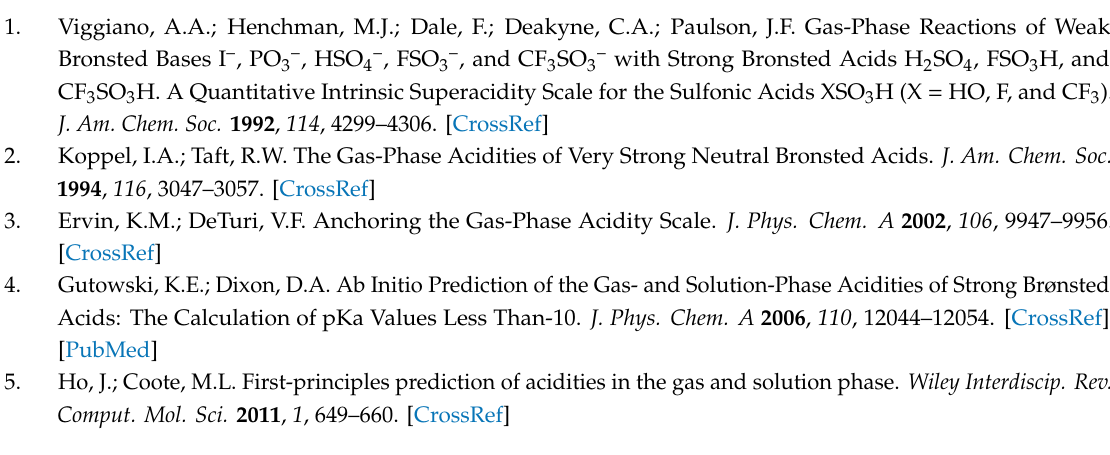
Supplementary Materials: The following are available online. Table S1. Experimental (gas-phase electron di ff raction—GED) and calculated (B3LYP / cc-pVTZ // MP2 / cc-pVDZ // МР 2 / cc-pVTZ) geometries (angstroms and degrees) of unsubstituted BSA [42], Table S2. Experimental (GED) and calculated (B3LYP / cc-pVTZ // МР 2 / cc-pVTZ) geometries (angstroms and degrees) of 4-CH 3 -BSA molecule and conformer I of 3-NO 2 -BSA molecule [49], Table S3. The conformational composition of gas phase (Boltzmann distribution, 298 K) and the sum of the donor-acceptor stabilization energies ( Σ E (2) ) characterized the strength of the formed IHB in conformers with IHB, Data: Cartesian coordinates (Å) of optimized geometry (DFT / B3LYP / cc-pVTZ) of acid conformers and deprotonated